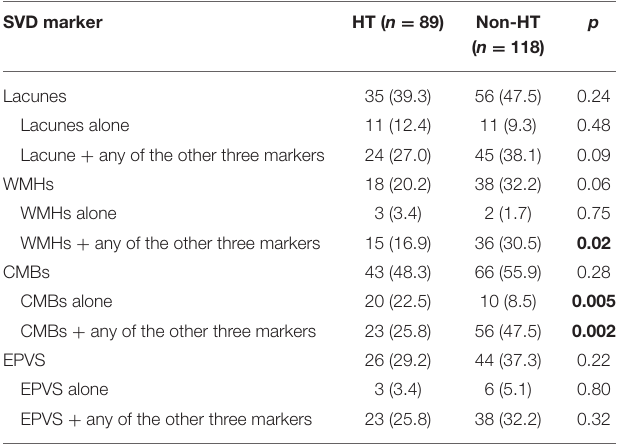
TABLE 3 | Comparison of the components of the SVD score between patients with or without HT. SVD marker HT ( n =